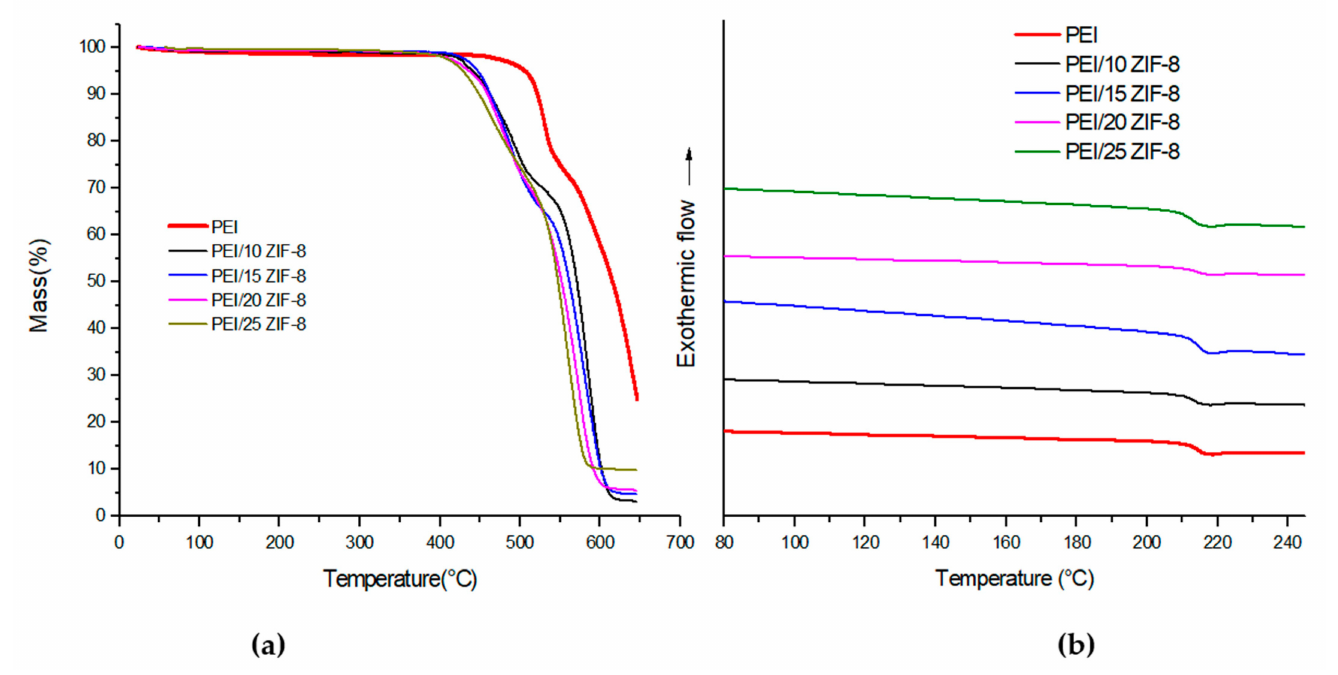
Figure 5. ( a ) TGA mass loss curves and ( b ) DSC thermograms of the mixed-matrix